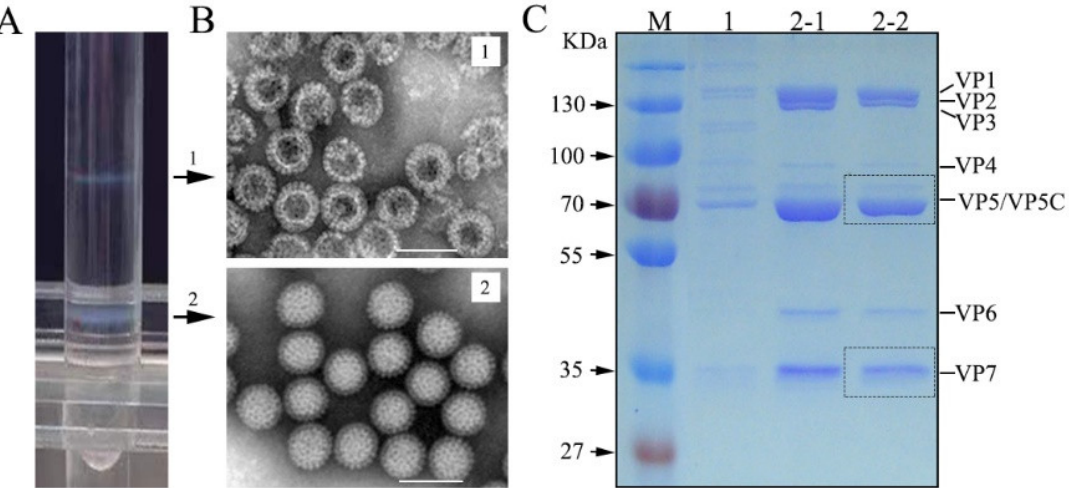
Figure 1. Purified particles and structural protein identification of GCRV. ( A ) CsCl gradient ( ρ , 1.20– 1.45 g/cm 3 ) centrifugation to separate GCRV particle components using a SW41 Ti tube (~12 mL). Arrowheads indicate the position corresponding to the upper and lower band in each gradient. ( B ) TEM of negatively stained virions. 1, top component particles/double empty capsid shell; 2, intact virion. ( C ) SDS-PAGE analysis of structural proteins of purified GCRVs. M, standard protein marker; lane 1 (5 μL), protein components in the upper band; lanes 2-1 (6 L) and 2-2 (4 L), protein components in the lower band. The scale bars represent 100 nm. The VP5 and VP7 bands in the dashed box were prepared for in-gel digestion and LC-MS/MS assays. GCRV, grass carp reovirus; LC-MS/MS, liquid chromatography-tandem mass spectrometry; TEM, transmission electron mi- croscopy; SDS-PAGE, sodium dodecyl sulfate-polyacrylamide gel electrophoresis.